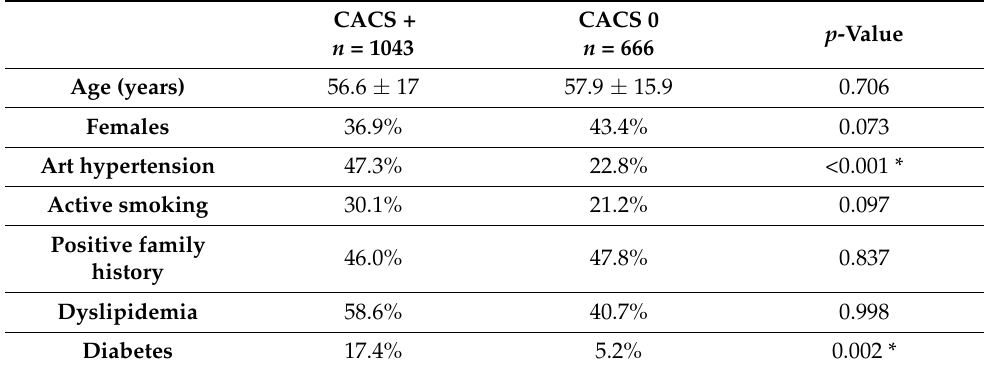
Table 2. Cardiovascular risk factors in CACS 0 and CACS positive (>1 AU)